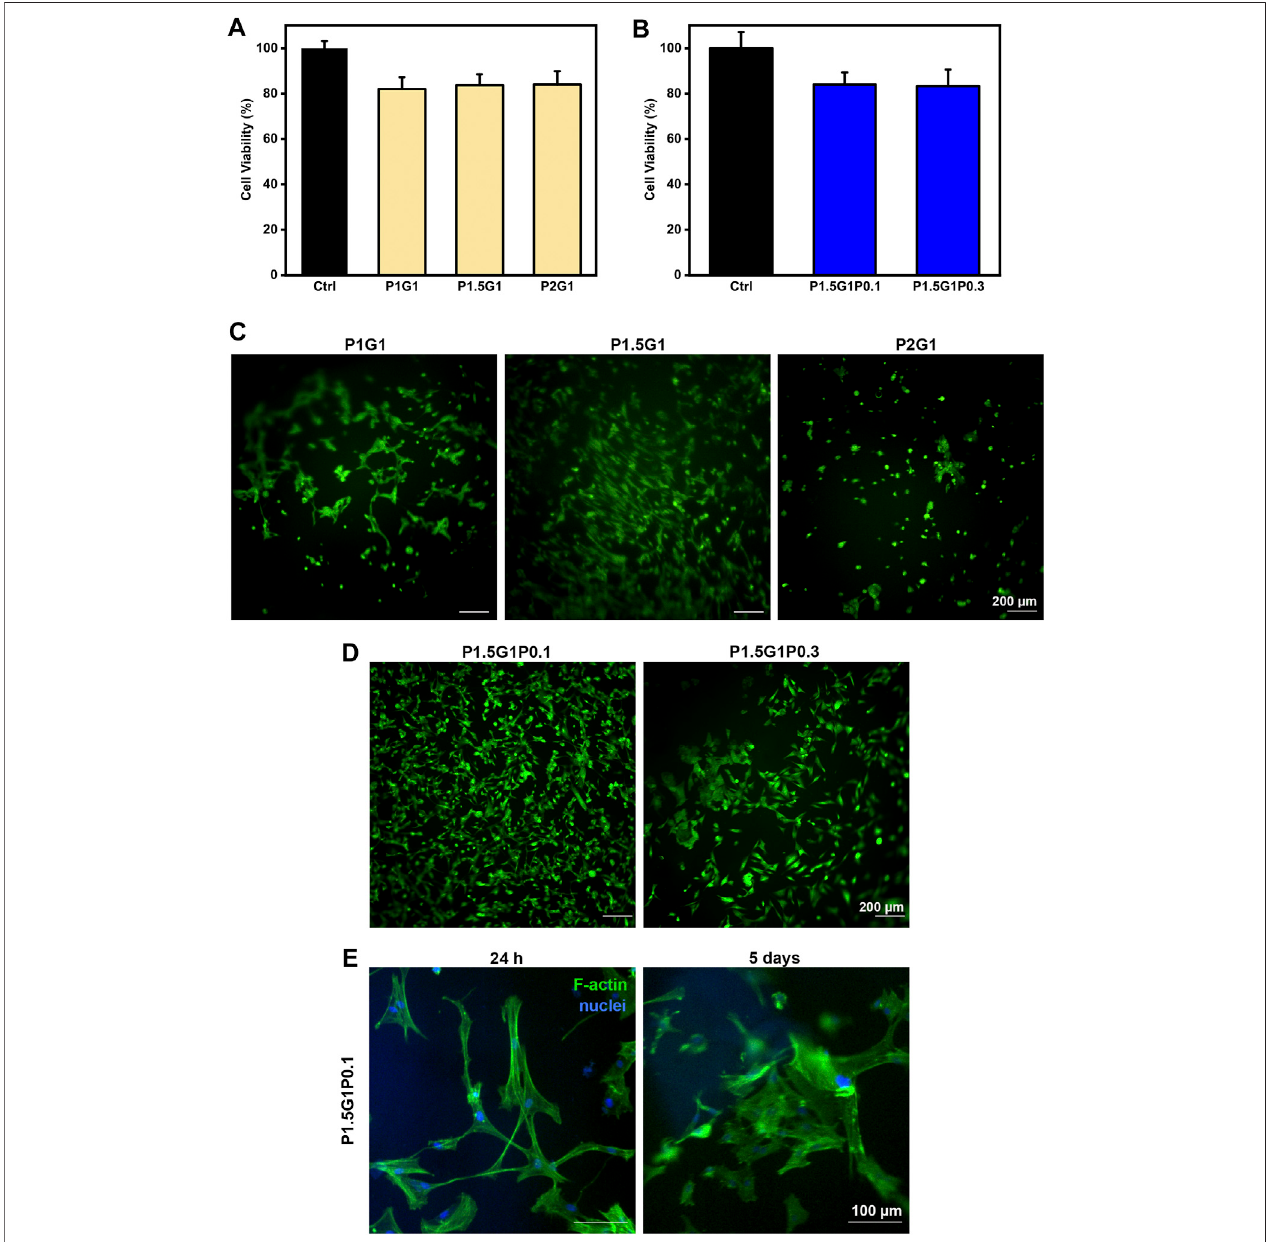
FIGURE 8 | In vitro cell characterization of hydrogels. (A) , (B) indirect cytocompatibility tests of human cardiac fi broblasts, evaluated at 24 h on hydrogel extracts, respectively from (A) pristine and (B) doped samples. Controls are represented by cells cultured in a medium not containing extracts. (C) , (D) Viability of HCFs in direct contact with (C) pristine and (D) doped samples, respectively, after 24 h culture time, evaluated through Live/Dead imaging (scale bars = 200 µm). (E) DAPI/F-actin staining of HCFs at 24 h and 5 days for morphological evaluation (scale bars = 100 µm).